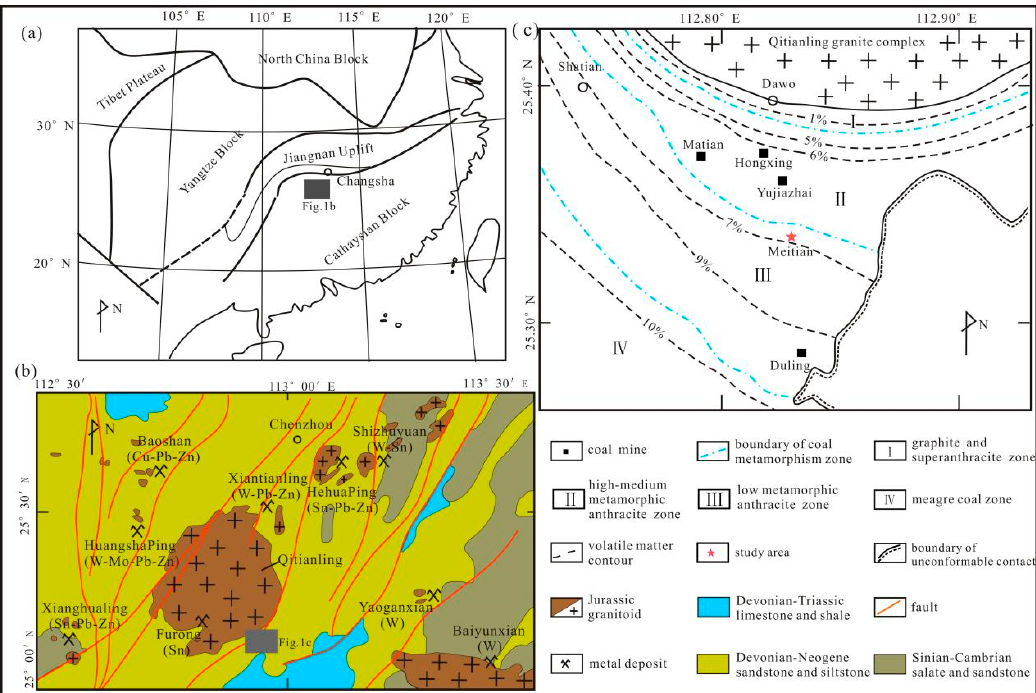
Figure 1. ( a ) Sketch map showing the regional geology of the central Nanling region, South China. ( b ) Distribution of Jurassic igneous rocks and associated polymetallic mineral deposits in the central Nanling region, South China, including the location of the Meitian Coalfield (modified from Li et al., 2007) [27]. ( c ) Schematic diagram showing metamorphic zones of the 12U and 12L Coals, including the location of the Meitian Mine (modified from Wang et al., 1999) [24].